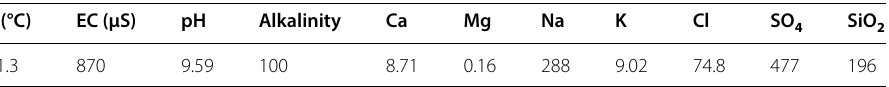
Table 2 Results of chemical analysis of MH-2B water sample by USUAL (all units in mg/L unless otherwise noted) T